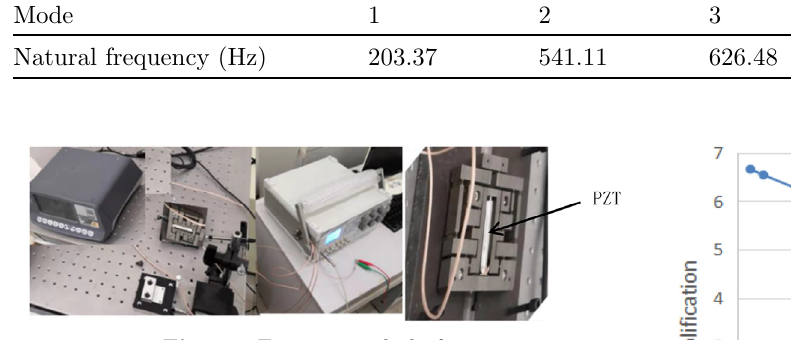
Fig. 10. Experimental platform.